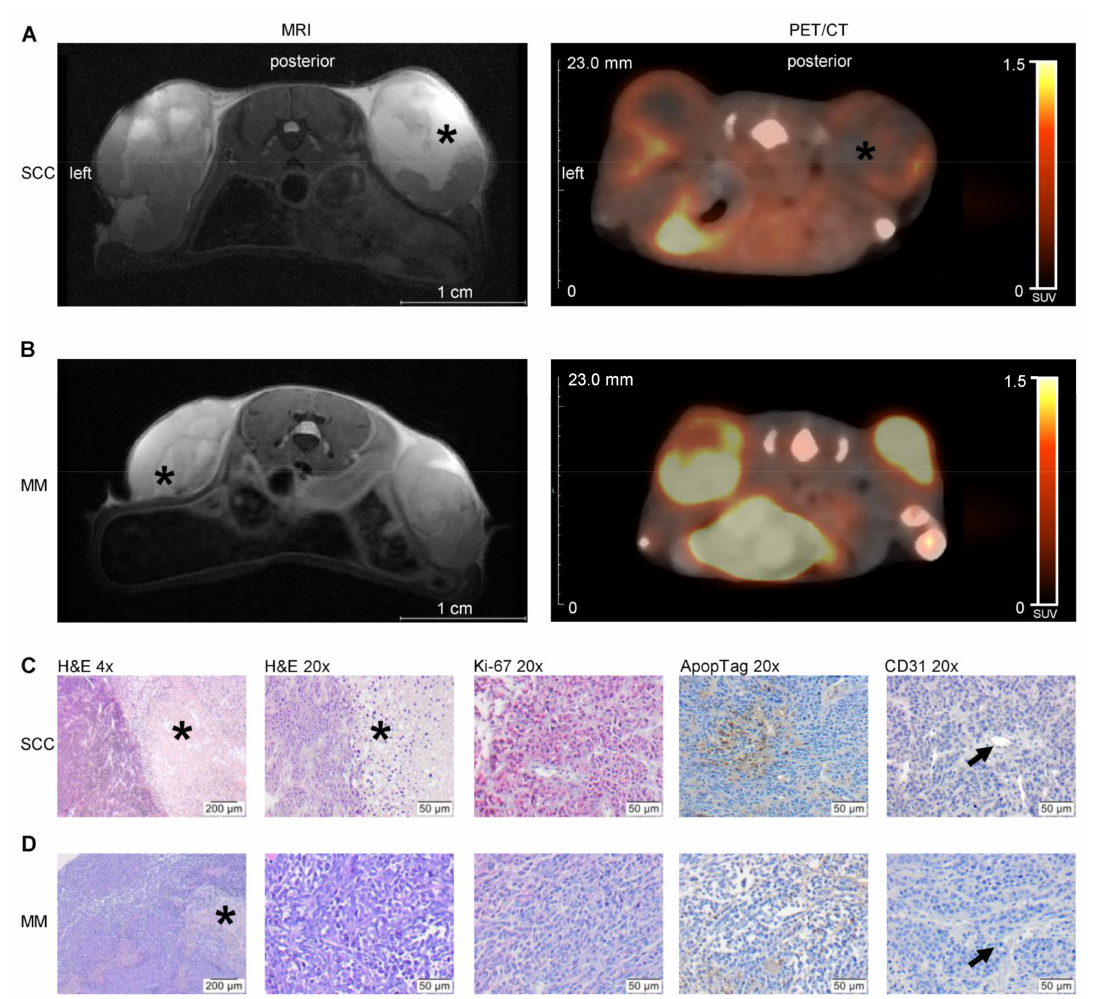
Figure 1. Representative MR (T2 weighted, axial, week three) and PET/CT images ([ 18 F]FDG; summed images, axial slices, week three) ( A ; SCC and B ; MM) as well as histological and immunohistochemical images of H&E, Ki-67, ApopTag ® and CD31 staining ( C ; SCC and D ; MM) for characterization of tumour biology. In NSG mice 1 × 10 6 tumour cells of either squamous cell carcinoma (SCC) or malignant melanoma (MM) were injected s.c. into the left and right hind flank. Over the three-weeks observation time, anatomical tumour volumes were measured by MRI, and metabolic tumour volumes were determined by PET/CT. Measurements were performed one, two and three weeks after tumour cell implantation. After in vivo characterization, the tumours were excised and prepared for histological analysis. Asterisks mark central tumour necrosis. Arrows point to CD31-positive